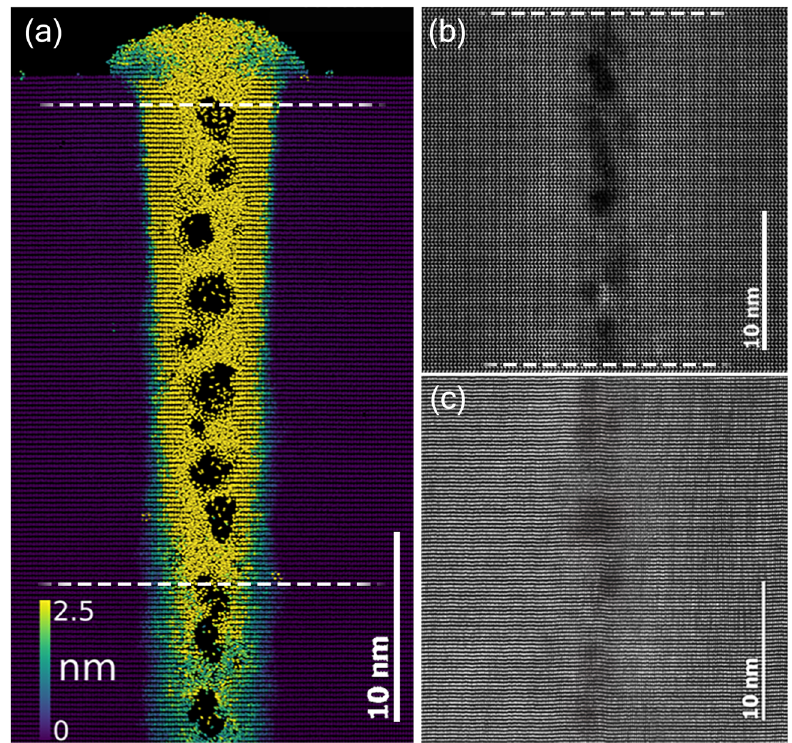
Fig. 4 Cross-sectional images of the fi nal state of the track formed by a 185 MeV Au ion near the surface. a Simulated track with the colour scale representing the magnitude of displacement of the atoms from their initial positions. b Simulated transmission electron microscopy – high-angle annular dark- fi eld image corresponding to the area delimited by the dashed lines in ( a ). c Corresponding experimental cross-sectional image of a track near the surface of a sample irradiated with a fl uence of 1 × 10 11 cm – 2 .